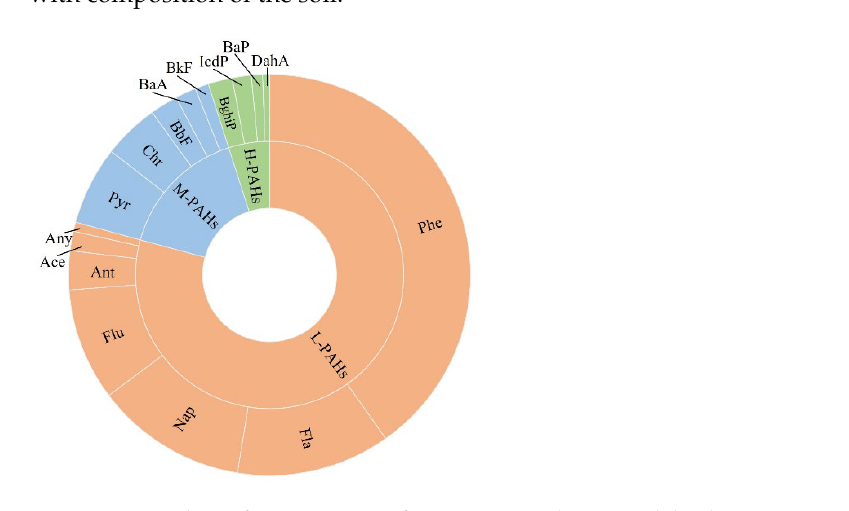
Figure 6. Ring chart of concentrations for 16 PAHs in plants near lake shores. L-PAHs: Low-molecular-weight PAHs. M-PAHs: Medium-molecular-weight PAHs. H-PAHs: High-molecular-weight PAHs.